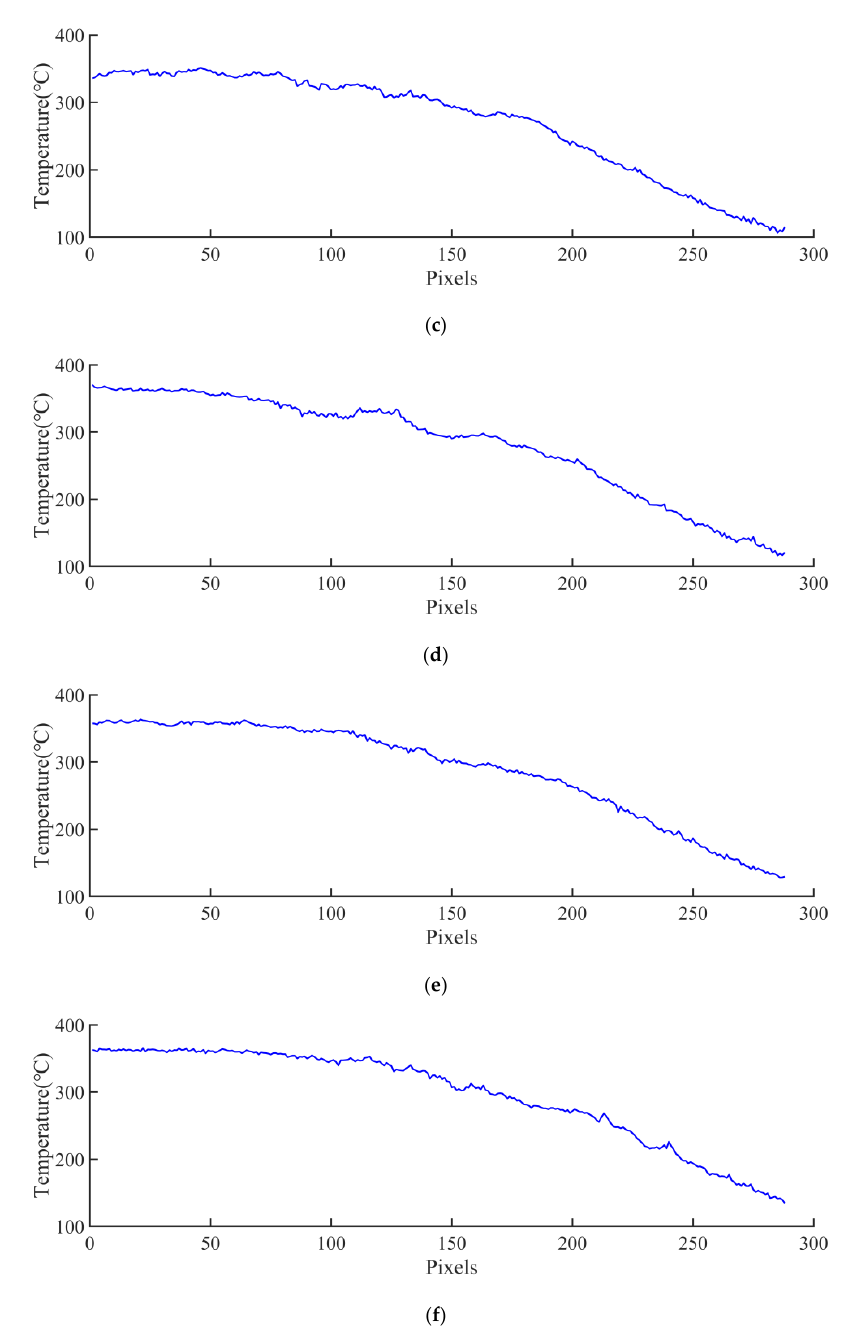
Figure 7. Linear temperature distribution curve of the weldment surface parallel to the welding direction at different times: ( a ) t = 4 s; ( b ) t = 8 s; ( c ) t = 12 s; ( d ) t = 20 s; ( e ) t = 25 s; ( f ) t = 29